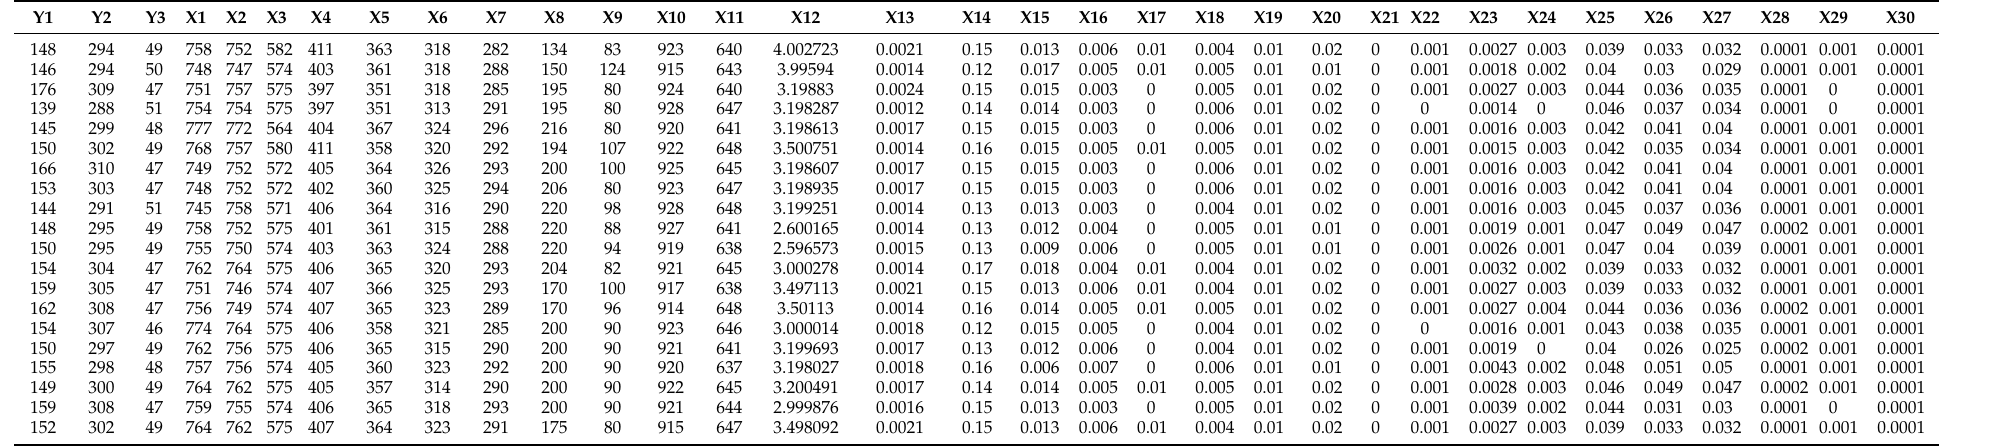
Table 1. The X and Y is the sets of process parameters and product quality attributes. The X contains the parameters of temperature, steeling time, iron composition, and so on. The product attribute Y includes three quality attributes, i.e., yield stress, tensile stress, and plastic strain